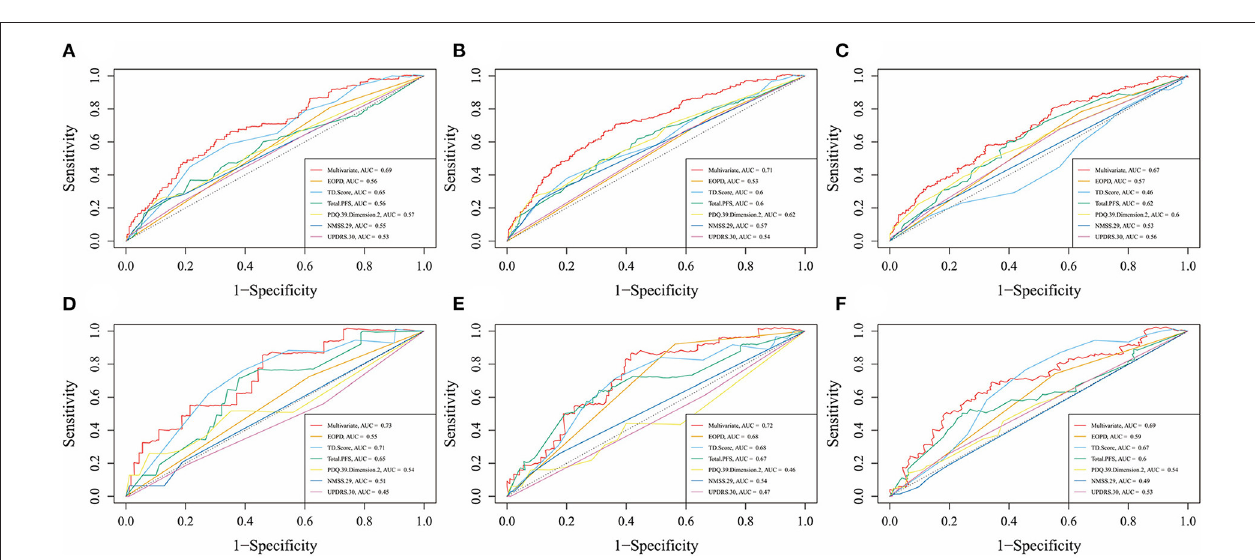
FIGURE 4 | Time-dependent receiver operating characteristic (td-ROC) curves of multivariate and each factor at different survival times in the training set and test set. (A) td-ROC of 5-year survival, in the training set; (B) td-ROC of 7-year survival, in the training set; (C) td-ROC of 10-year survival, in the training set; (D) td-ROC of 5-year survival, in the test set; (E) td-ROC of 7-year survival, in the test set; (F) td-ROC of 10-year survival, in the test set.